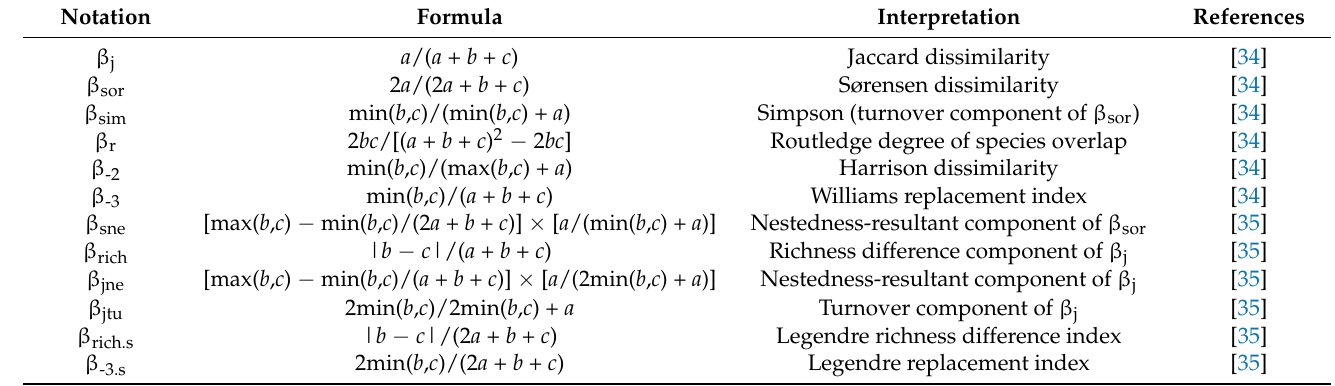
Table 1. List of assessed incidence-based β -diversity measures. Formulas were retrieved from the R packages ‘betapart’ (Baselga et al. [34]) and function ‘betadiver’ of the ‘vegan’ package (Oksanen et al. [35]). ‘ a ’: total number of species that occur in both assemblages (shared species); ‘ b ’ and ‘ c ’: number of species that occur in one assemblage but not in the other (exclusive